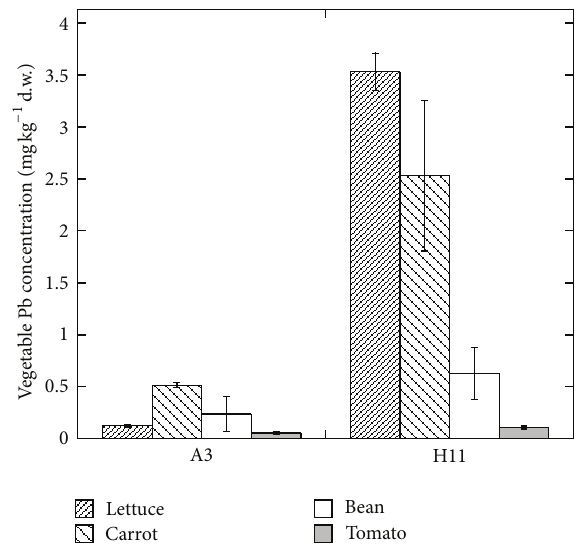
Figure 6: Pb concentrations (mgkg −1 d.w.) in lettuce, carrot, bean and tomato grown on orchard soils with similar total Pb but pH of 6.2 (A3) and 4.9